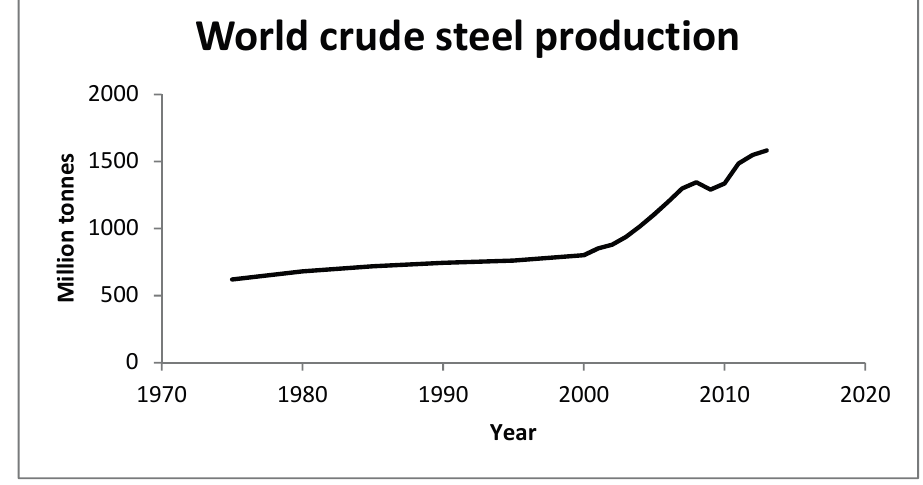
Figure 1. Crude steel produced between 1970–2013 (adapted from World steel